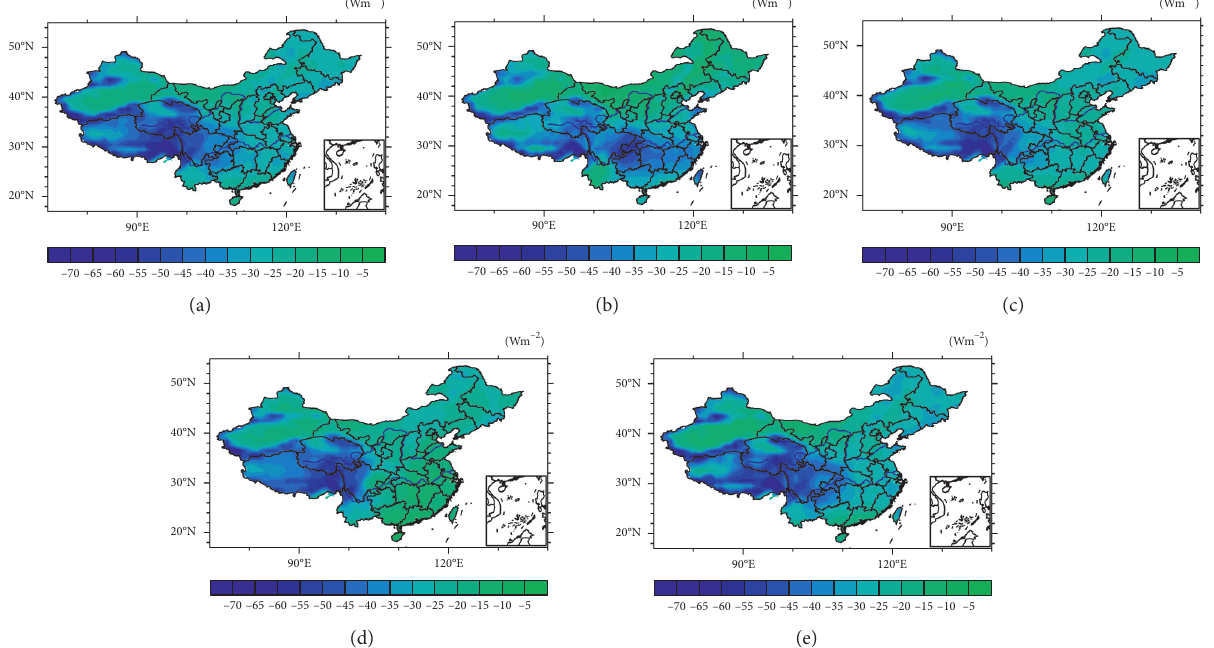
Figure 8: Differences in LER (Wm − 2 ) in China between all-sky conditions and clear-sky conditions during 2001–2016: (a) annual, (b) spring, (c) summer, (d) autumn, and (e) winter.